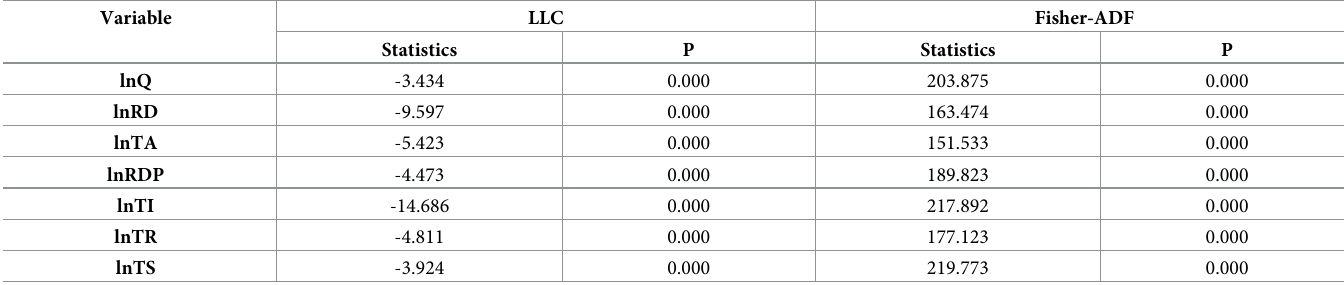
Table 2. Panel data stationarity test